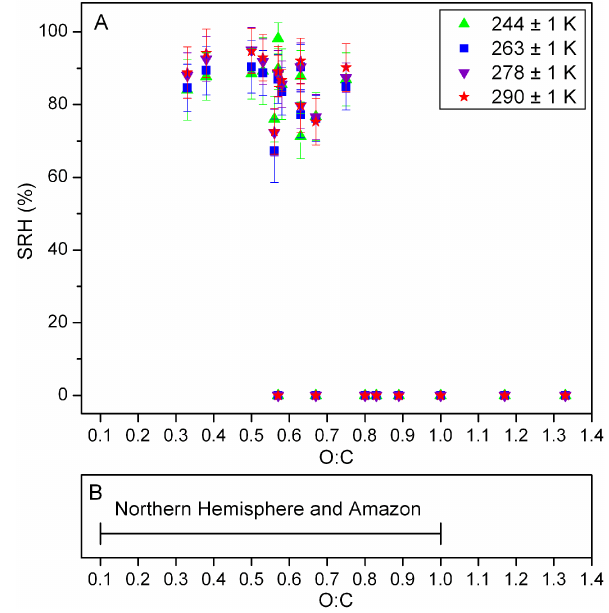
Figure 4. (a) SRH of mixed organic–ammonium sulfate particles as a function of O:C measured at four different temperatures. Different symbols represent the different temperatures. Bars for the data are 95% confidence intervals considering σ of multiple SRH measurements and the uncertainty from the calibration. Data at SRH = 0% indicate liquid–liquid phase separation was not ob- served. Data plotted are summarized in Table 4. OIR = 2.0 ± 0.1 in all the experiments. (b) Range of the average O:C of organic material in particles from measurements at many locations in the Northern Hemisphere and the Amazon.